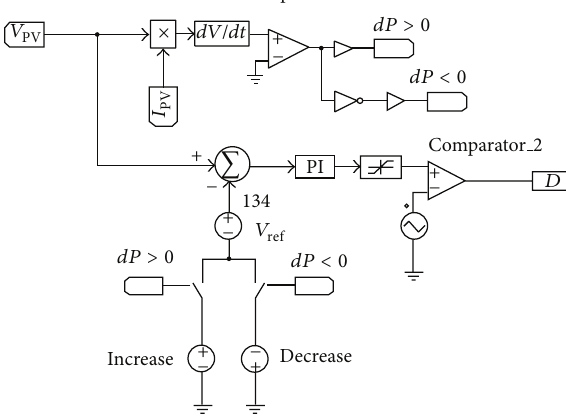
Figure 7: Implementation of P&O technique.